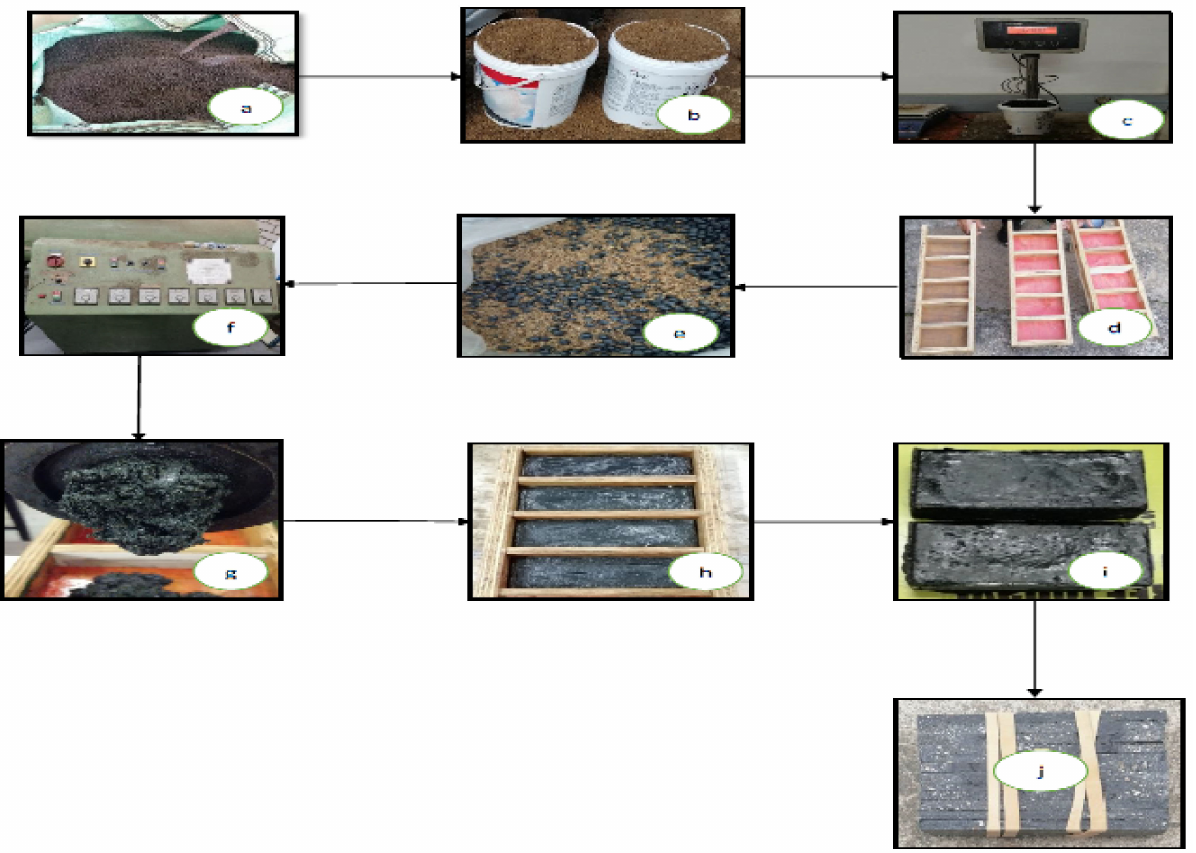
Figure 8. Manufacturing of plastic sand brick